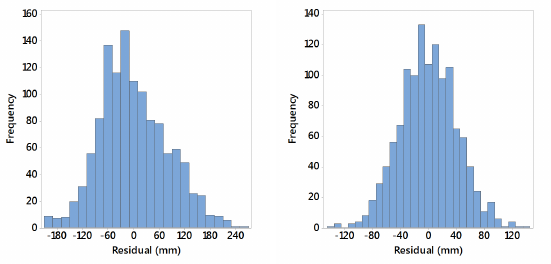
Figure 3: Histograms of the residuals for the BL model (left) and the new kinematic model solutions.